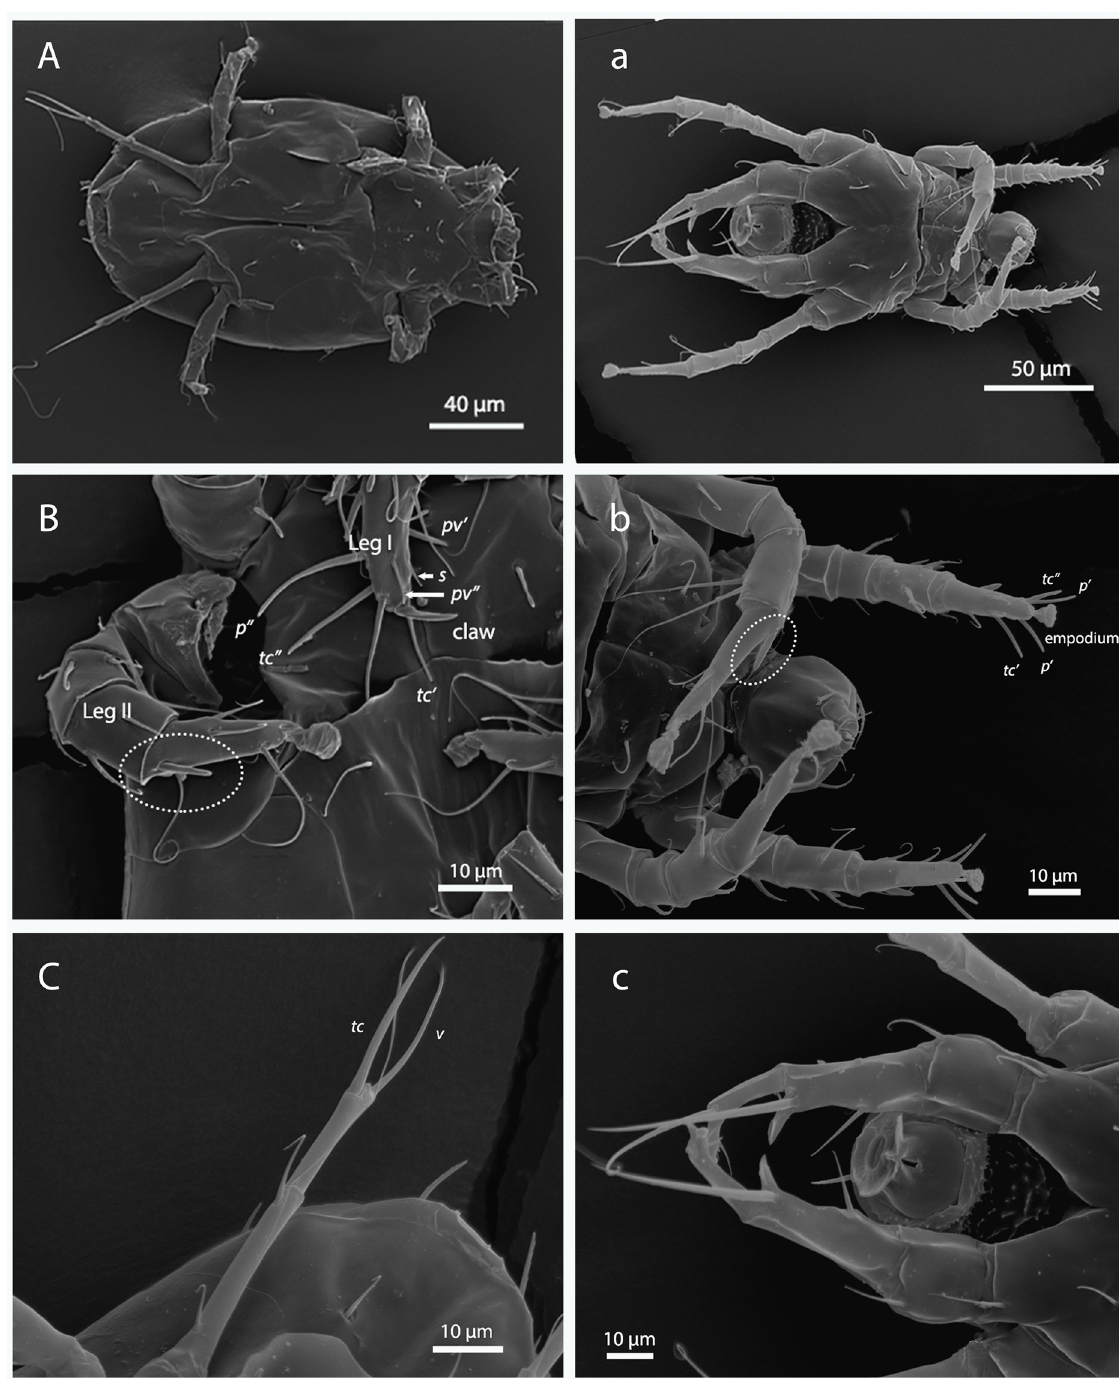
Fig 2. Morphology of female (A-C) and male (a-c) Polyphagotarsonemus latus . A-a) ventral panoramic view; B-b) chaetotaxy of tibiotarsus of Leg I [eupathidium p´ (anteroproral), p” (posteroproral), tc´ (anterotectal), and tc” (posterotectal); setae pv´ (anteroprimiventral), pv” (posteroprimiventral) and s (subunguinal)] and solenidion of Leg II (within the ellipse); C-c) Leg IV [setae v" (posteroventral) and tc" (posterotectal)].